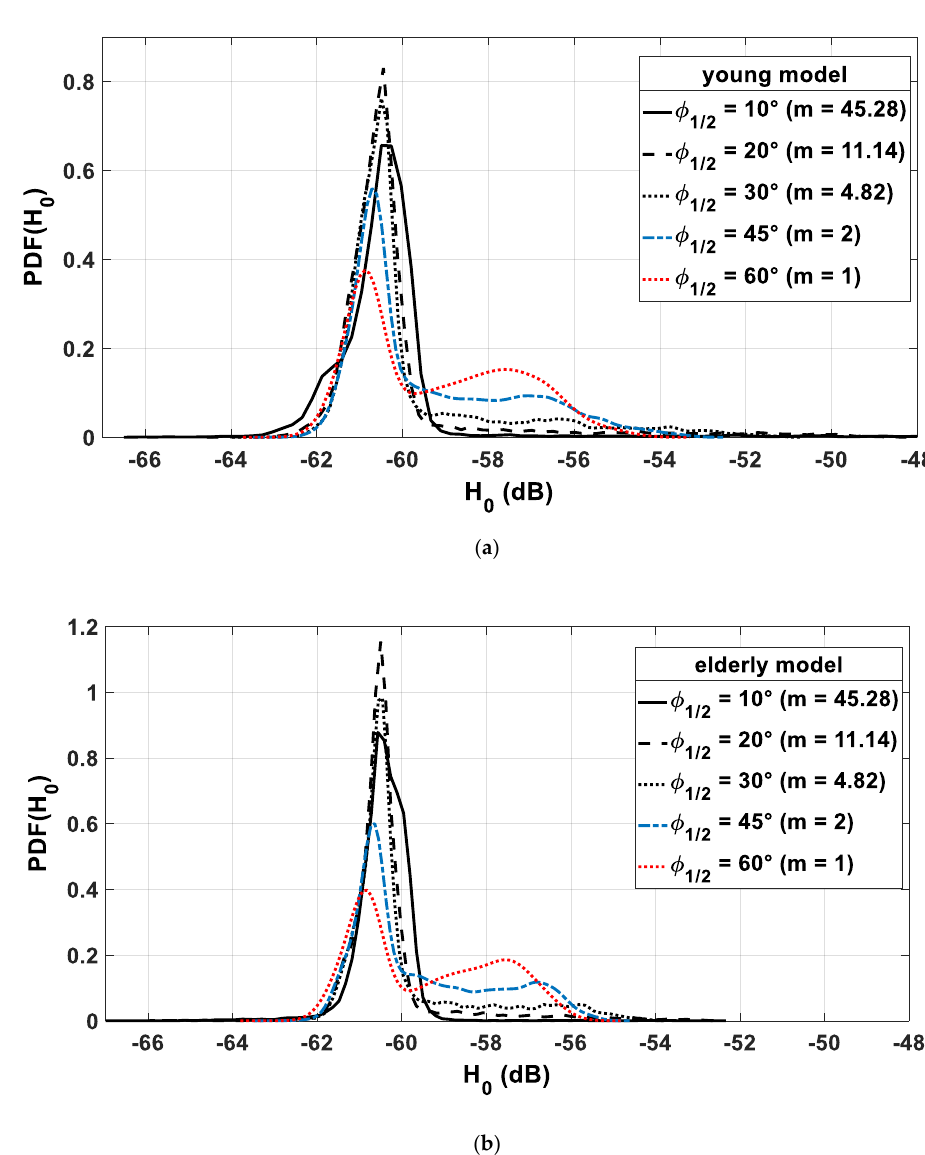
Figure 8. PDFs of 𝐻 0 for different values of 𝜑 1/2 with young model ( a ) and with elderly model ( b